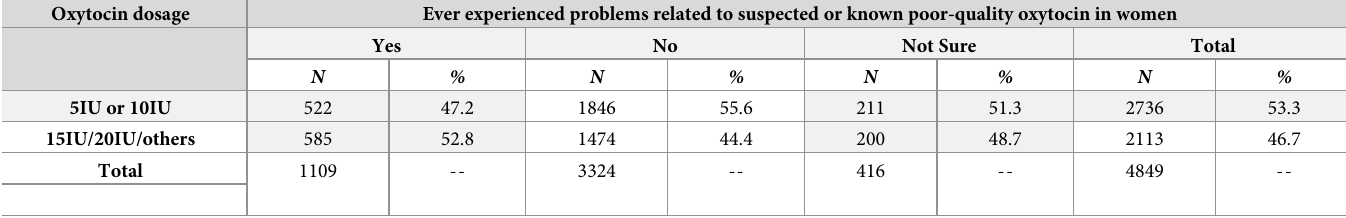
Table 6. Comparison of respondents’ experience of oxytocin failure by oxytocin dosage used for prevention of PPH in women. Oxytocin dosage